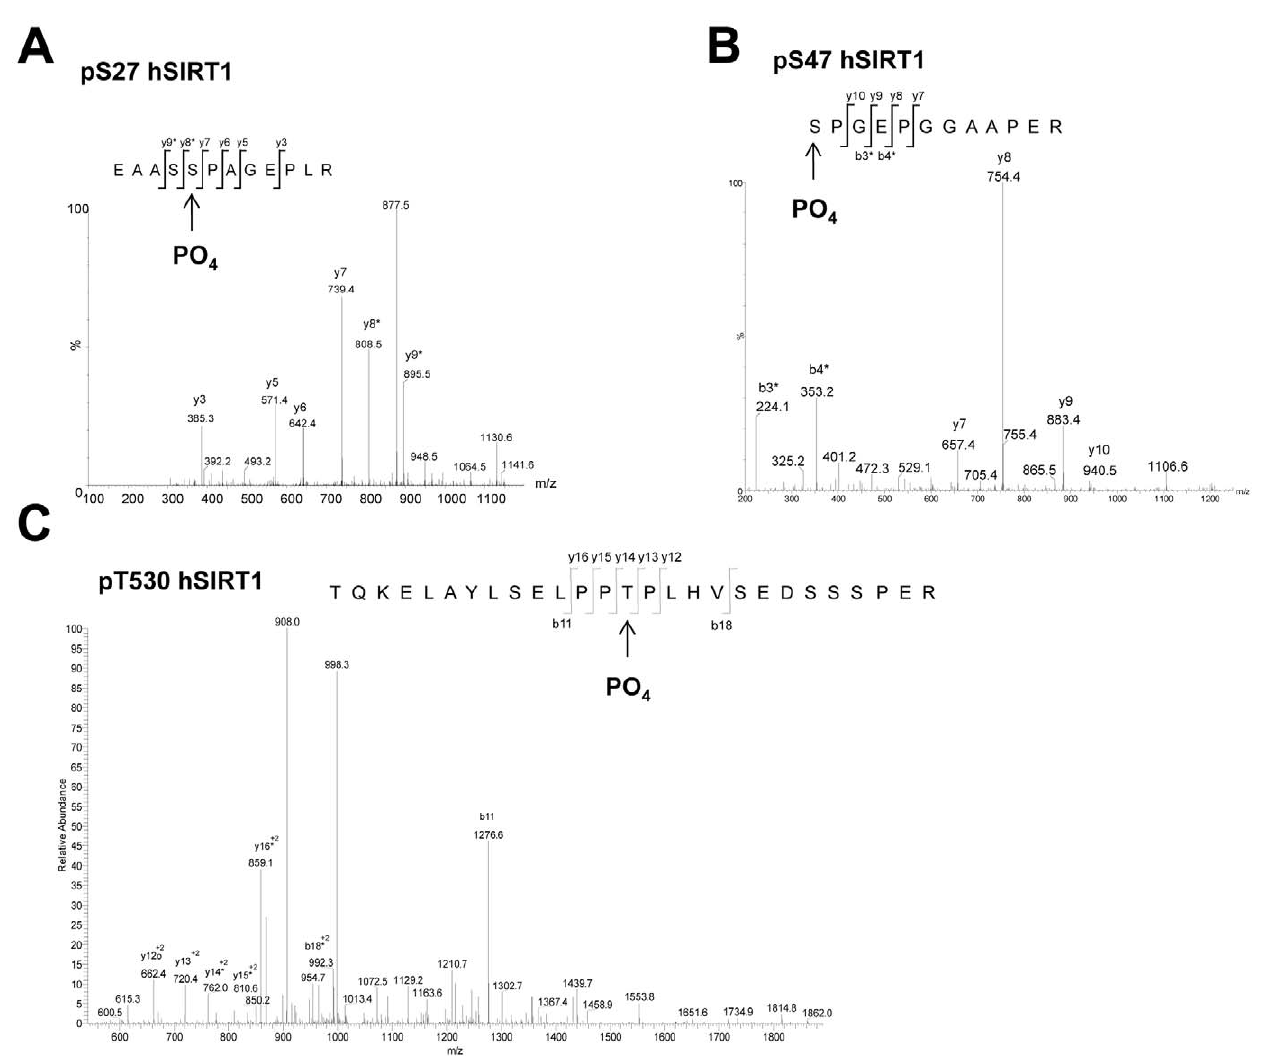
Figure 5. Phosphorylation of hSIRT1. A and B , These peptide MSMS fragmentation spectra were obtained from the ex vivo FL hSIRT1 IP samples after SDS PAGE and in-gel digestion. The spectrum in A shows phosphorylation of pS27 with neutral loss of 98 Da from the y8*, y9* and y10* ions (indicated with a *). Spectrum B shows phosphorylation of pS47 with neutral loss of 98 Da from the b3* and b4* ions, but no neutral loss from the y ions. C , The MSMS spectrum shown here was derived from in vitro experiments with hSIRT1 (a.a. 170–701) and shows phosphorylation of pT530 with neutral loss of 98 Da for y14* to y17*. These spectra were produced from Mascot database searches with high confidence scores using data generated from a nanoLC LTQ FT mass